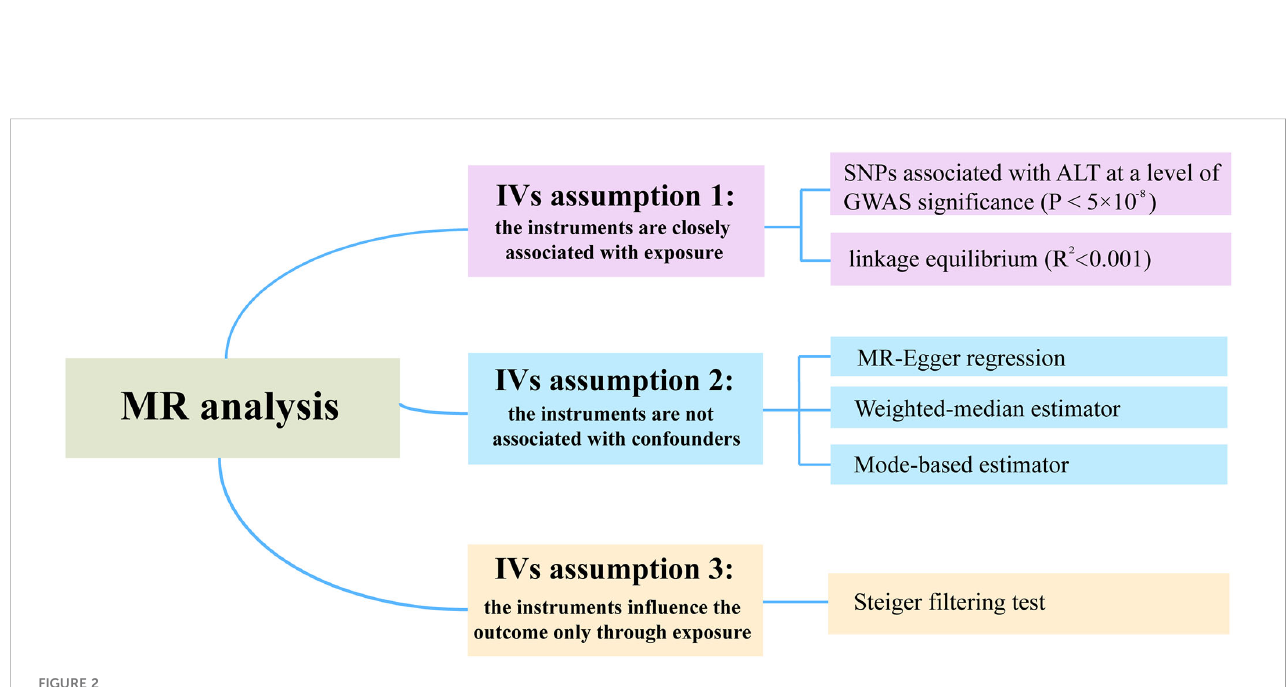
FIGURE 2 Strategies to satisfy the three assumptions of IVs in MR analysis.